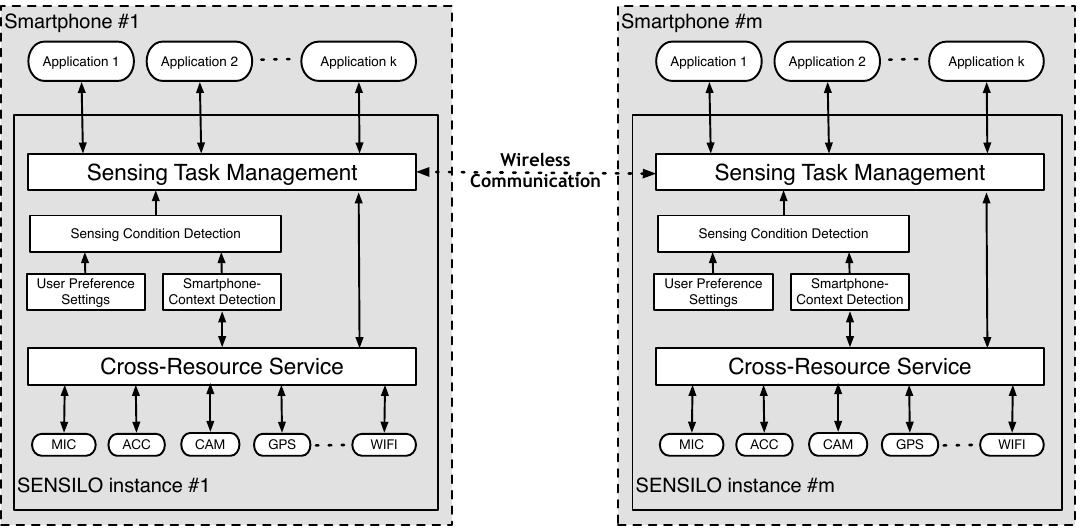
Figure 9. SENSILO software